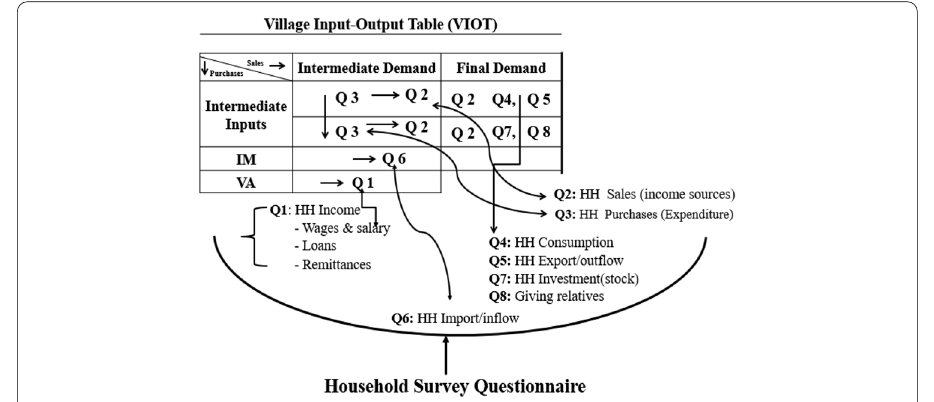
Fig. 3 Data flows and allocations to the